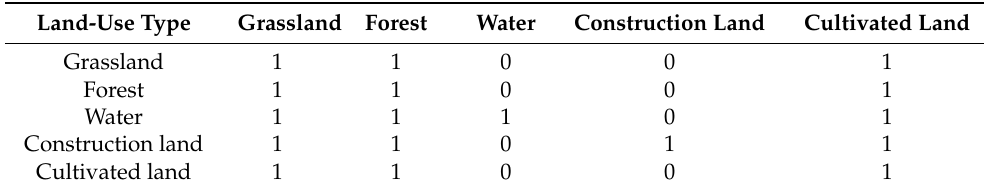
Table 2. Land-use conversion matrix, where the horizontal land use describes the initial land-use state, and the vertical land use is the possible conversion pathways. Land-Use Type